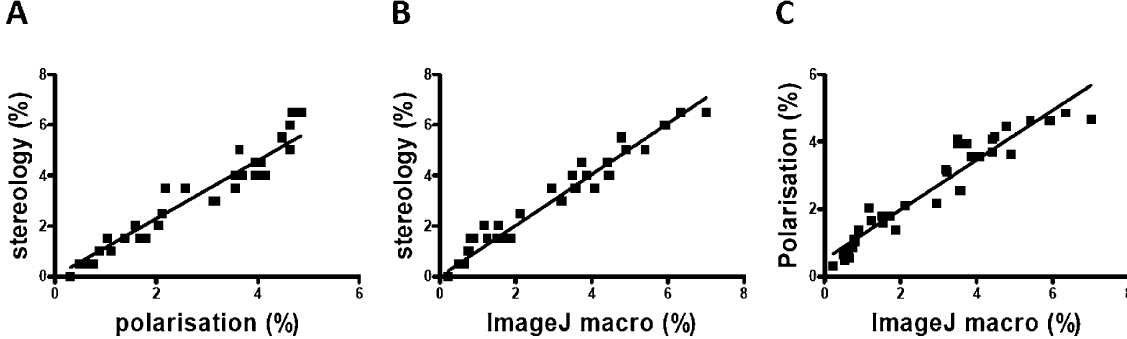
Fig. 5. We compared both analysis methods with traditional quantification of fibrosis using stereology. Both polarisation light microscopy (A) and the ImageJ macro (B) correlated strongly with stereology ( r 2 = 0 . 93, p < 0 . 0001, intercept at X = 0 is − 0.09 and r 2 = 0 . 95, p < 0 . 0001, intercept at X = 0 is 0.32, respectively). In addition, the ImageJ macro (C) correlated with polarisation microscopy as well ( r 2 = 0 . 92, p < 0 . 0001, intercept at X = 0 is 0.37).